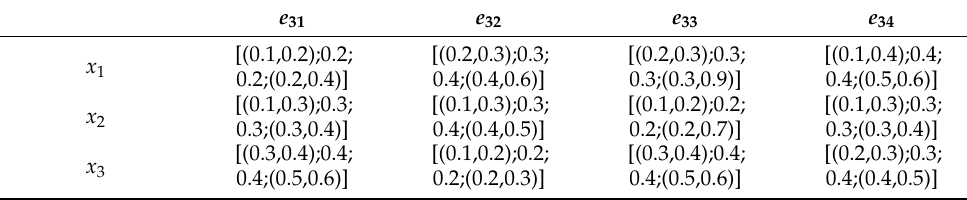
Table A12. The different risk evaluation values subordinated by influencing factors of B 3 at time t 3 .